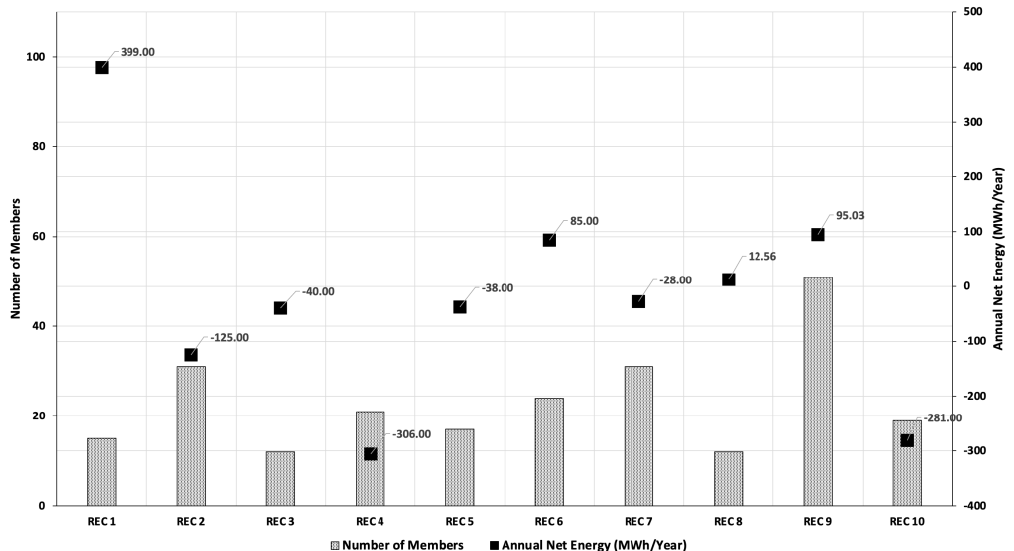
Figure 15. Number of members and annual net energy by REC (real REC not identified) — K-means.